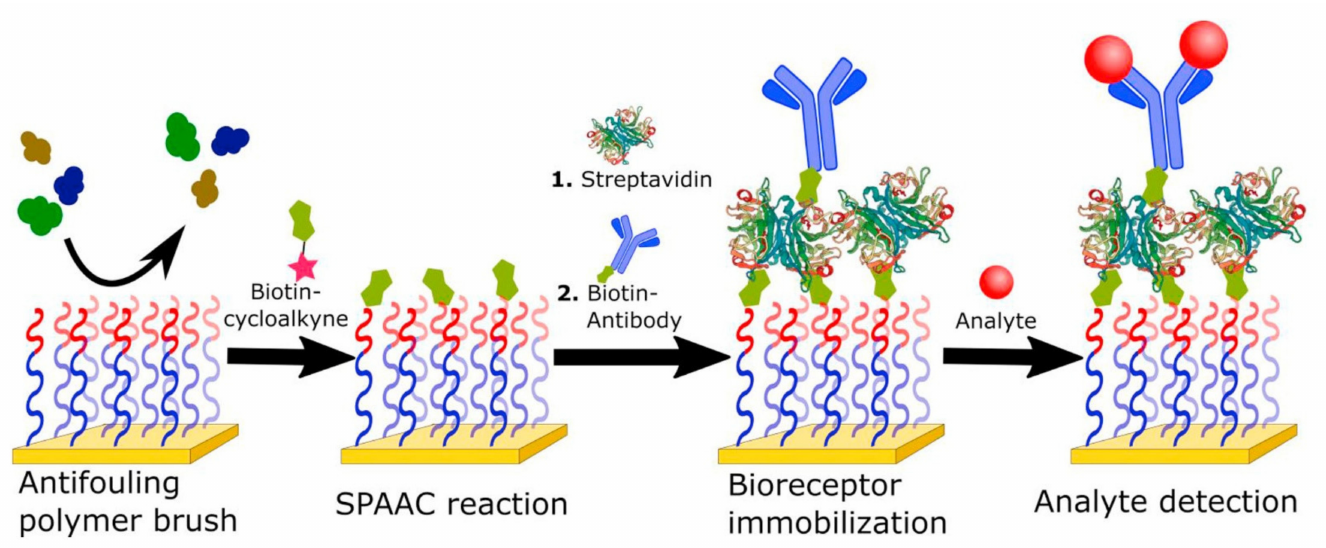
Figure 7. Schematic of a hybrid, multilayer SPR substrate composed of an antifouling polymer brush and biotin-captured streptavidin for the immobilization of biotinylated antibody. Adapted with permission from Parrillo et al. [90] (Copyright © (2017)